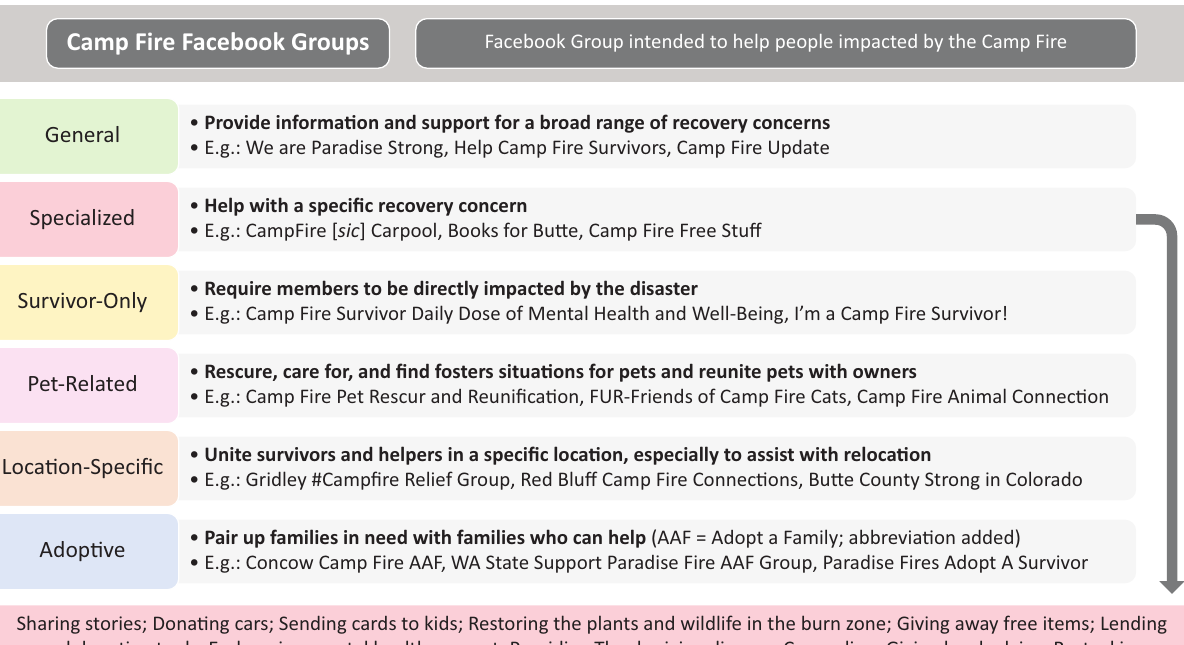
Figure 1. Six group identities of CFFGs with definitions and examples. In August 2020, the average group size was about 1,150 members with a median group size of 317 members (range: 5 to 25,000 leaders). The total number of mem‐ bers was over 100,000 members, though users could be members of multiple groups. The mean number of administrators and moderators per group was around two leaders, with the median and mode being one leader (range: 0 to 9 leaders).